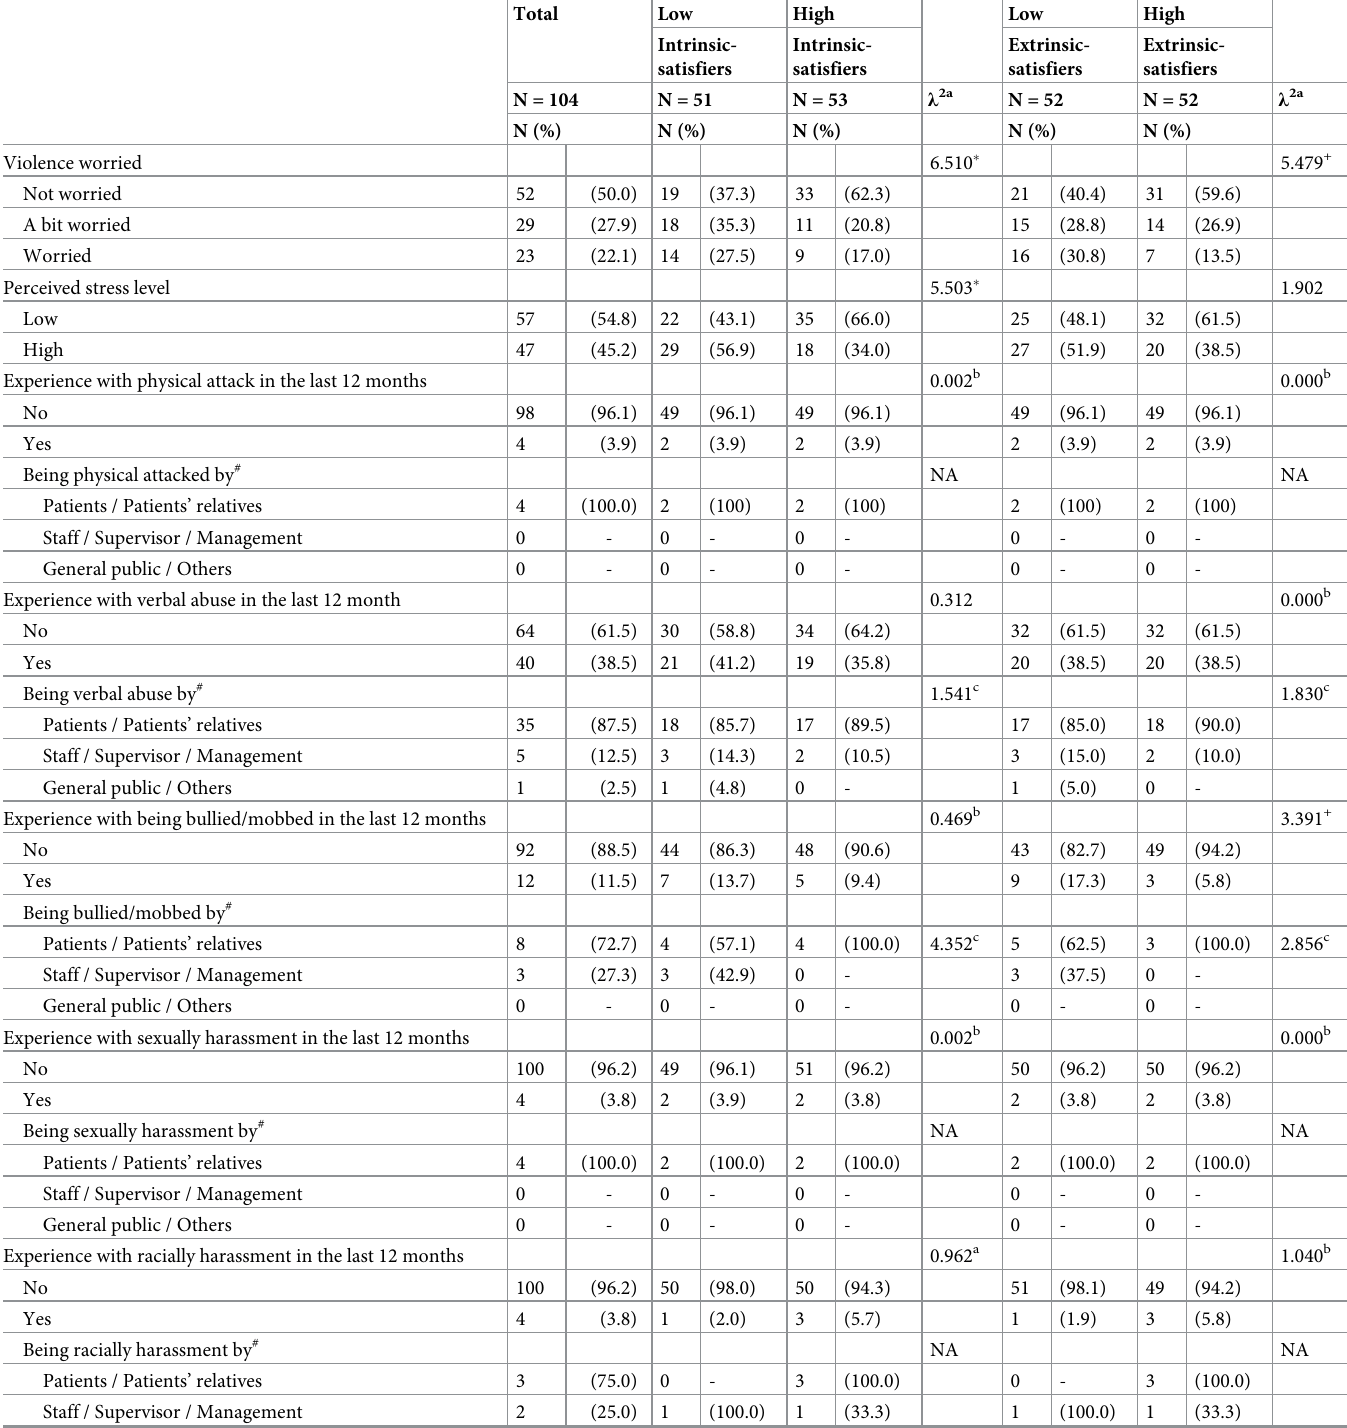
Table 3. Worry about WPV, perceived stress and experience with